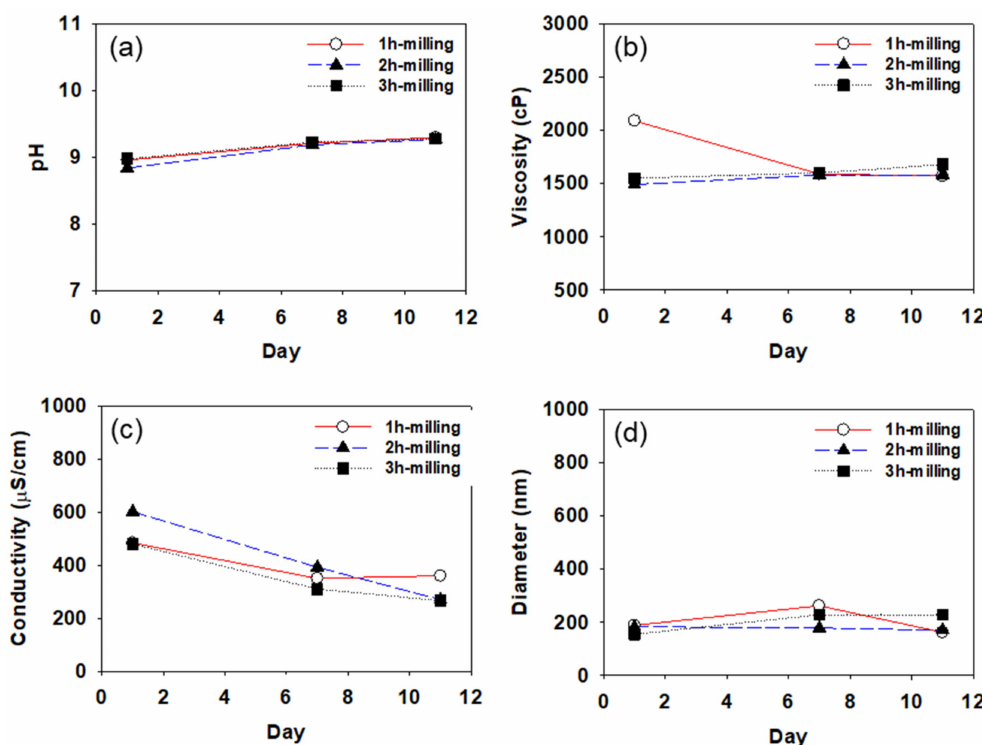
Figure 6. Variation of pH ( a ), viscosity ( b ), conductivity ( c ), and particle diameter ( d ) with time measured for the CB dispersions prepared using SMA-2000.